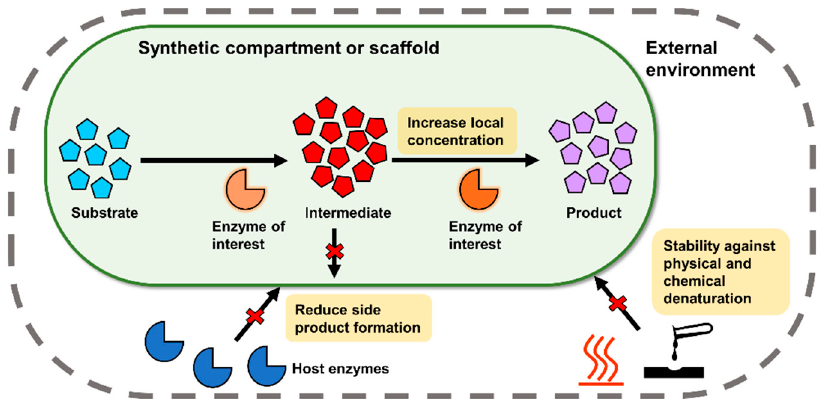
Figure 1. Enzyme compartmentalization or scaffolding has the potential to improve the efficiency of enzymes or metabolic pathways. Such strategies can also reduce the impact of interference from the external environment, either from the host cell or an ex vivo setting.